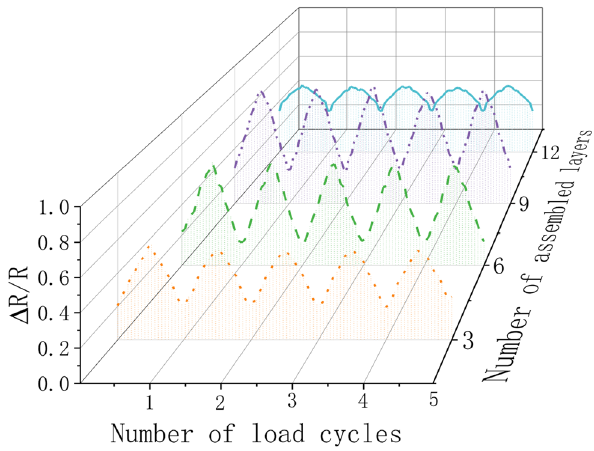
Figure 7: Relationship between change rate of resistance and mid - span displacement of varied double - layer CNTFS in tension